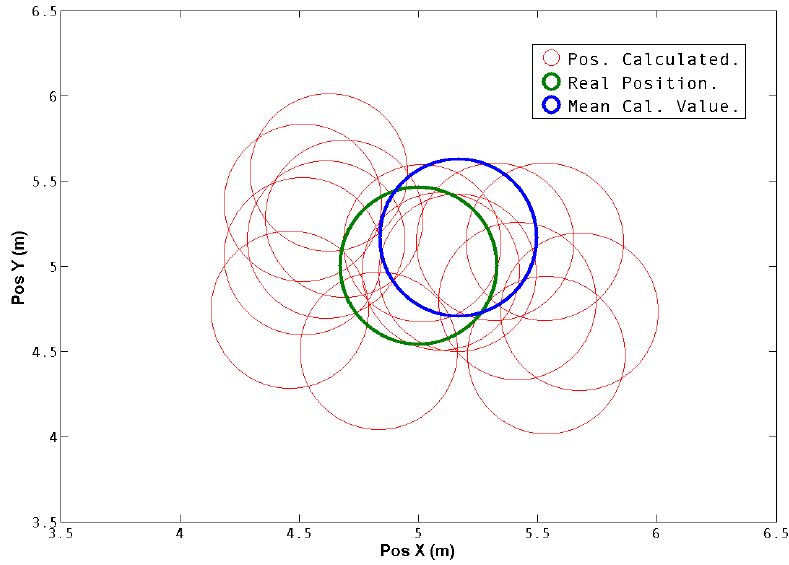
Figure 9. Obstacle Position (Real vs . Estimated). The red circles denote the estimated obstacle position. The green one shows the real position of the obstacle and the blue is the mean value of the calculated positions. All positions were translated to a common reference frame.